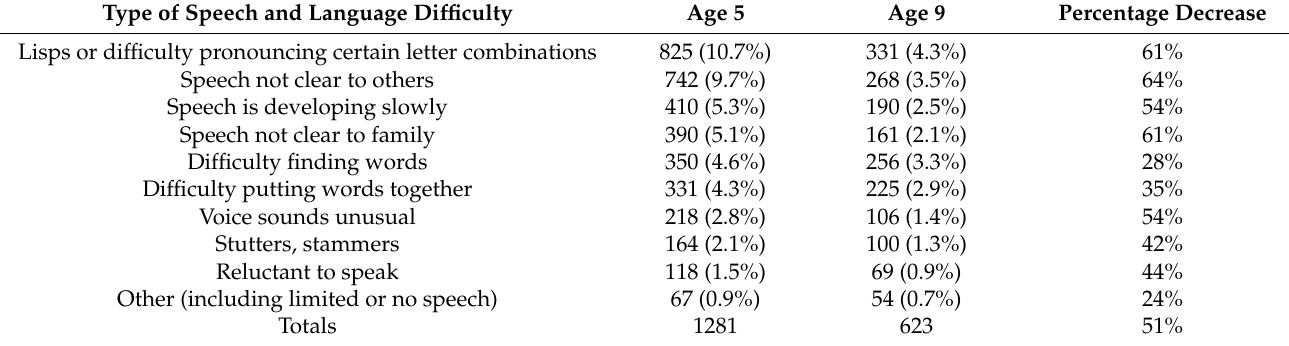
Table 1. The number and percentage of children with a speech and language difficulty at ages 5 and 9 and the percentage decrease for each type of difficulty.